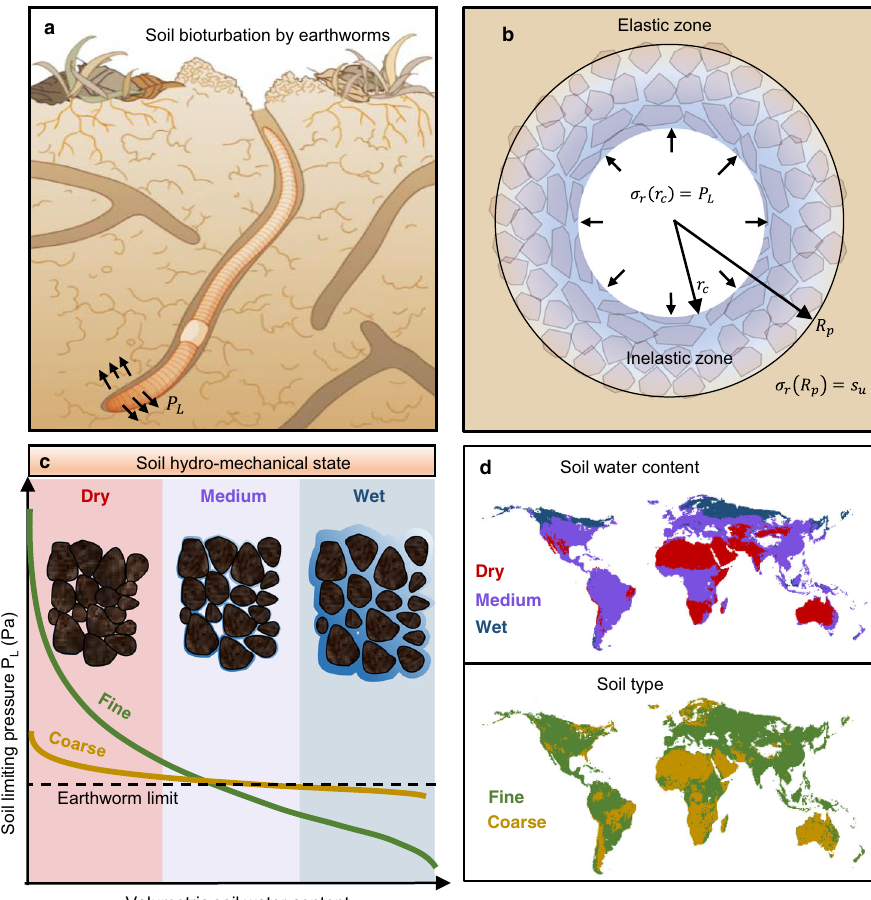
Fig. 1 Earthworm bioturbation activity in structured soil. a Subterranean bioturbation relies on earthworms ’ ability to mechanically penetrate and deform the soil using their fl exible hydroskeleton, which is b modeled considering penetration and cavity expansion transverse to the earthworm body where radial stresses σ r exerted by the earthworm from the local cavity of size r c . Yielding soil material is bounded by a remote elastic zone at a distance R P from the center of the cavity is dependent on c soil hydromechanical conditions that enable their hydroskeleton to form cavities. d Soil hydromechanical soil states can be mapped globally depending on soil water content and soil type, enabling inferences to earthworm